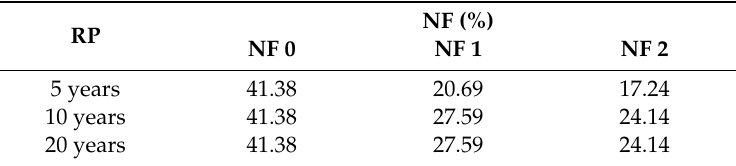
Table 6. Nodes flooding (NF) index for design storm